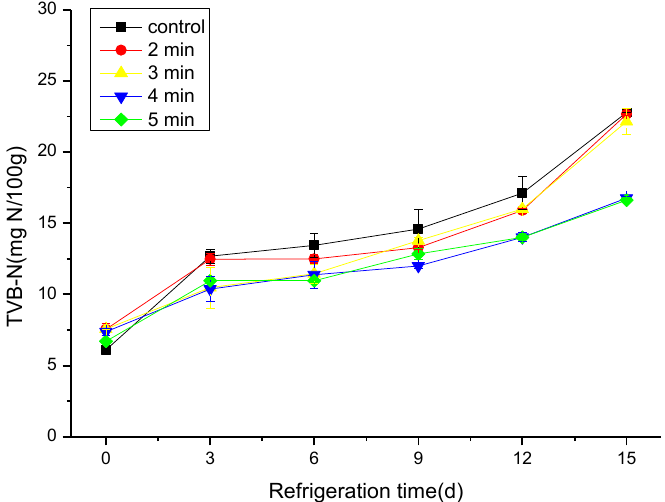
Figure 2. Changes in TVB-N of cold stored hairtail fish exposed to CAP at 50 kV voltage for various treatment times: 2, 3, 4, and 5 min. The non-treated sample was included as a